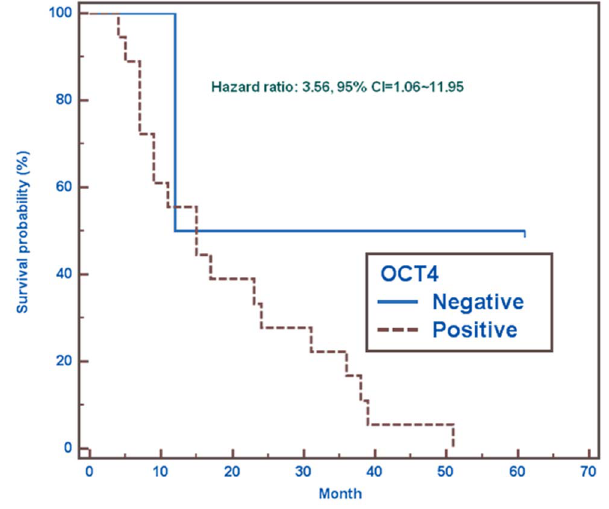
Figure 5. Correlation of immunoexpression of OCT-4 with survival. The Kaplan-Meier survival analysis after a 60-month follow-up showed that the estimated risk of the event of interest occurring in OCT-4 positive group was 256% higher than in OCT-4 negative group (Hazard ratio=3.56, 95% CI=1.06 , 11.95).